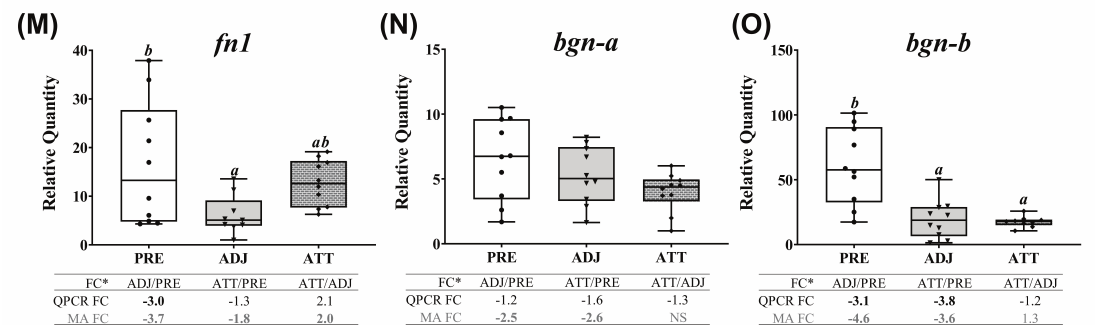
Figure 7. Correlation between the microarray and real-time quantitative polymerase chain reaction (QPCR) data, and QPCR confirmation of selected microarray-identified genes in theme 1 (Tables 1 and 3) associated with ECM, tissue repair, and wound healing. ( A ) Scatterplot of log 2 -transformed gene expression fold-changes (FC) between treatment groups calculated from the microarray log 2 ratios and log 2 -transformed QPCR relative quantity (RQ) ratios for all the QPCR-assayed transcripts. Each dot represents either an ADJ versus PRE, ATT versus PRE, or ATT versus ADJ comparison (i.e., one biological replicate) for a given target transcript. ( B – O ) Boxplots of QPCR data for the abundance of selected transcripts associated with ECM degradation, tissue repair / remodeling, and wound healing. Plots reveal median RQ values and interquartile ranges. Di ff erent letters above bars represent significant di ff erences between groups (one-way analysis of variance (ANOVA), Tukey’s post hoc test, p < 0.05). Inset table below each plot shows FC of GOI from microarray and QPCR. Numbers with negative sign represent fold downregulation calculated as the inverse of FC (i.e., − 1 / FC) for the values less than one. When more than one probe represents a transcript in the microarray, the average FC is shown in the inset table. Numbers of probes contributing to the average FC are provided in Tables 1 and 2. Bold letters indicate that a FC is statistically significant in QPCR or microarray by ANOVA and modified t -test, respectively. NS, found non-significant in the microarray. Refer to the heatmaps for each theme provided in Supplementary Figure S7. MA,